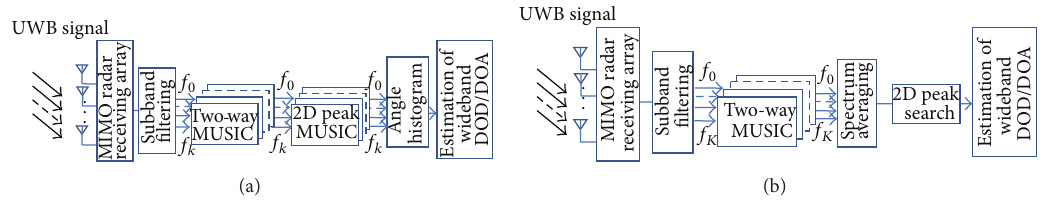
Figure 4: Block diagrams: (a) proposed and (b) conventional schemes.